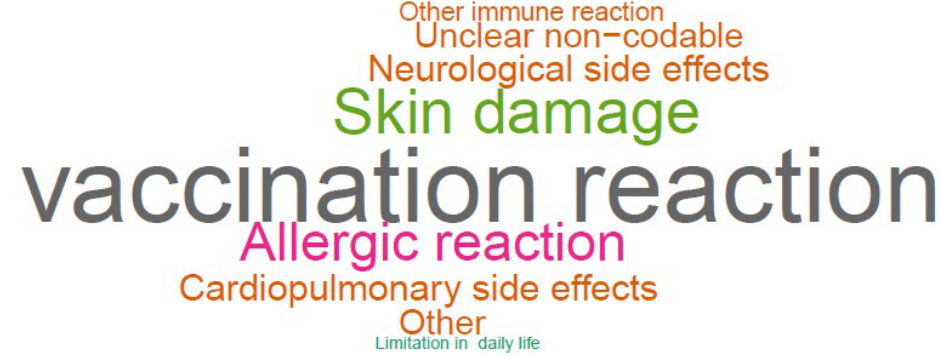
Figure 2. Word Cloud of experienced side effects, constructed from upper categories.